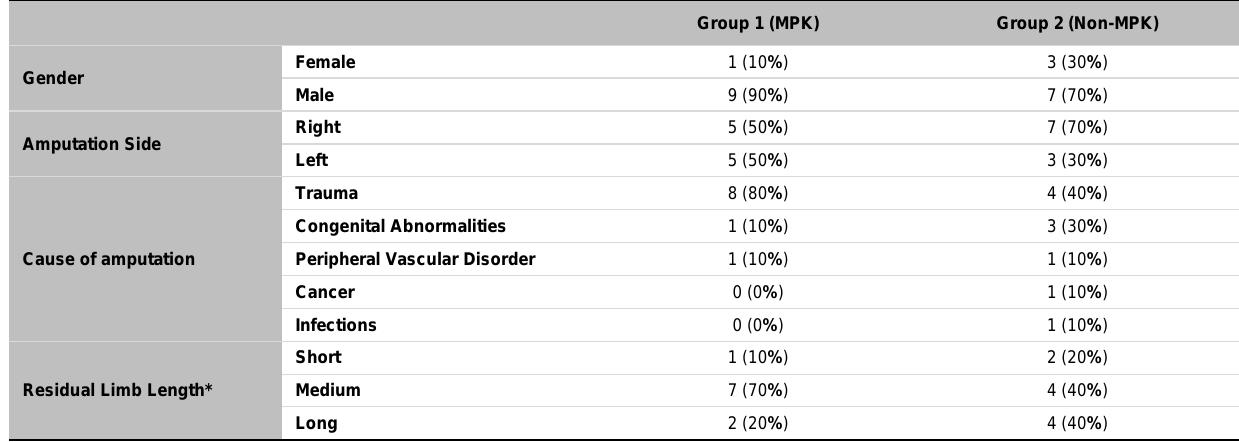
Table 2: Participant gender, side of amputation, cause of amputation and residual limb length.